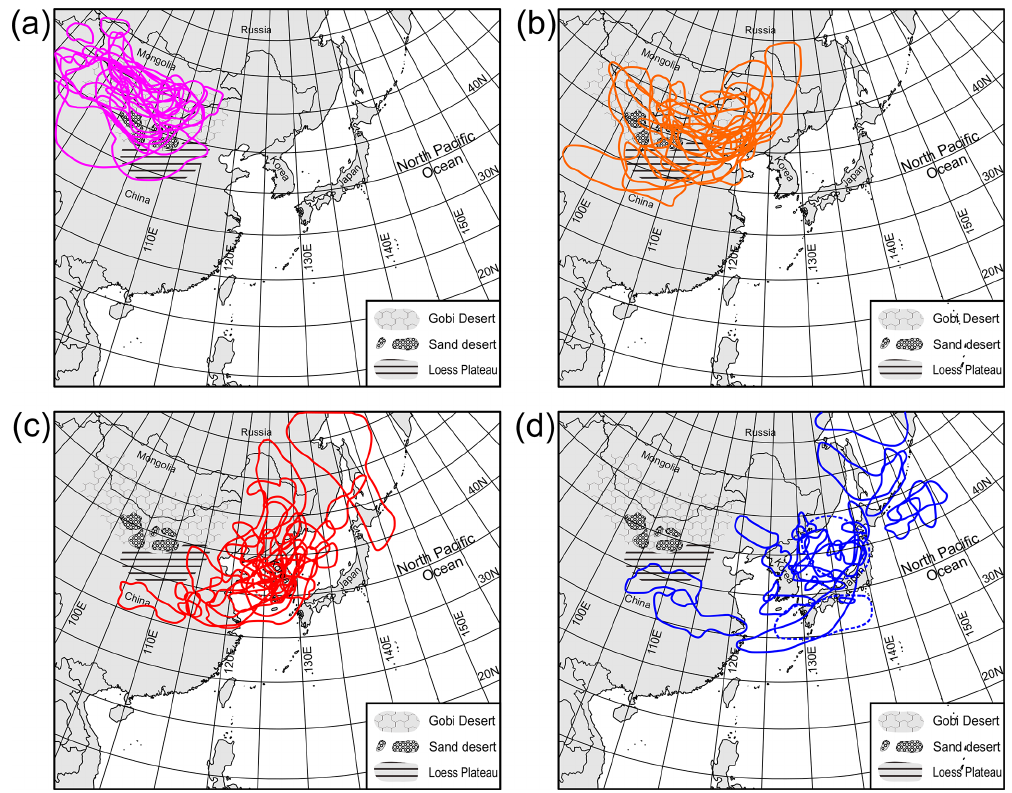
Figure 1. Dust storm outbreaks and migrations during 14 Asian dust events identified from the remote sensing images obtained from the Communication, Ocean, and Meteorological Satellite (COMS; 2011–2018) and the Multi-functional Transport Satellite-1R (MTSAT-1R; 2008–2010). The outbreak and migration path data for individual dust events are provided in Fig. S1. (a) The maximum extent of the dust event during the storm outbreak. (b) Migration of dusty air toward the Korean Peninsula. (c) Dusty air crossing the Korean Peninsula. (d) Migration of dusty air toward the North Pacific